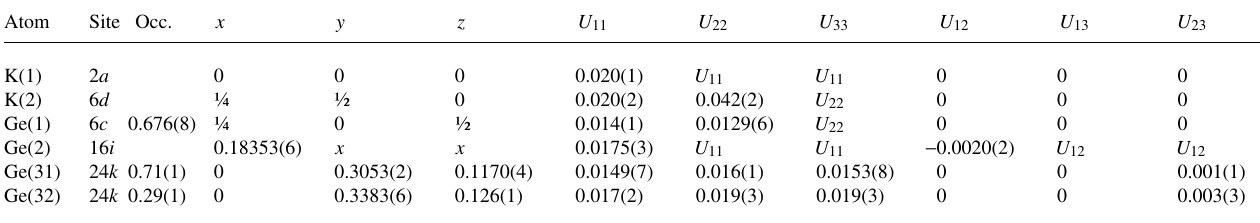
Table 2. Atomic coordinates and displacement parameters (in Å 2 ) .